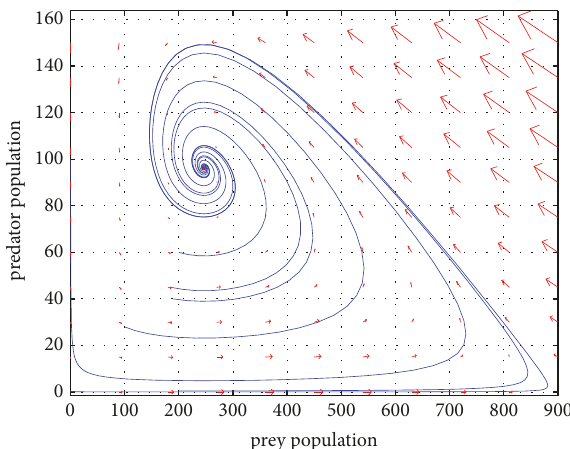
Figure4:Thephaseportraitofmodel(2)withweakAlleeeffect.The parameters are taken as 𝑥(0) = 260 , 𝑦(0) = 70 , 𝐴 = 150 , 𝑟 = 2.65 , 𝐾 = 900 , 𝑎 = 0.02 , 𝑐 = 0.215 , and 𝑚 = 1.06 ; 𝐸 unstable; a limit cycle is